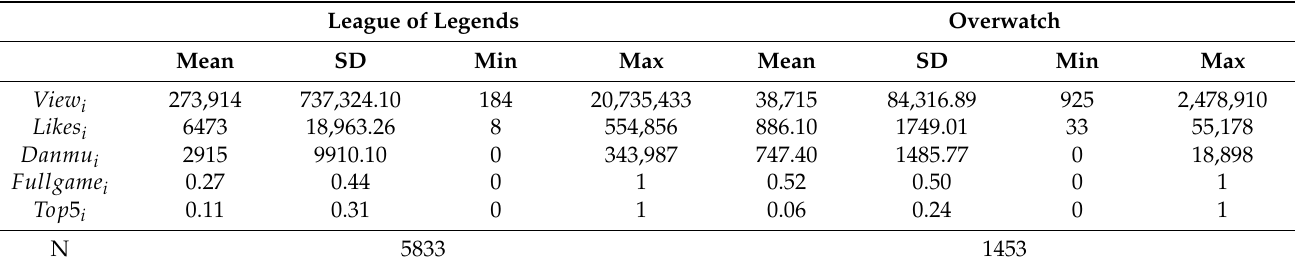
Table 3. Summary Statistics of All Esports-Related